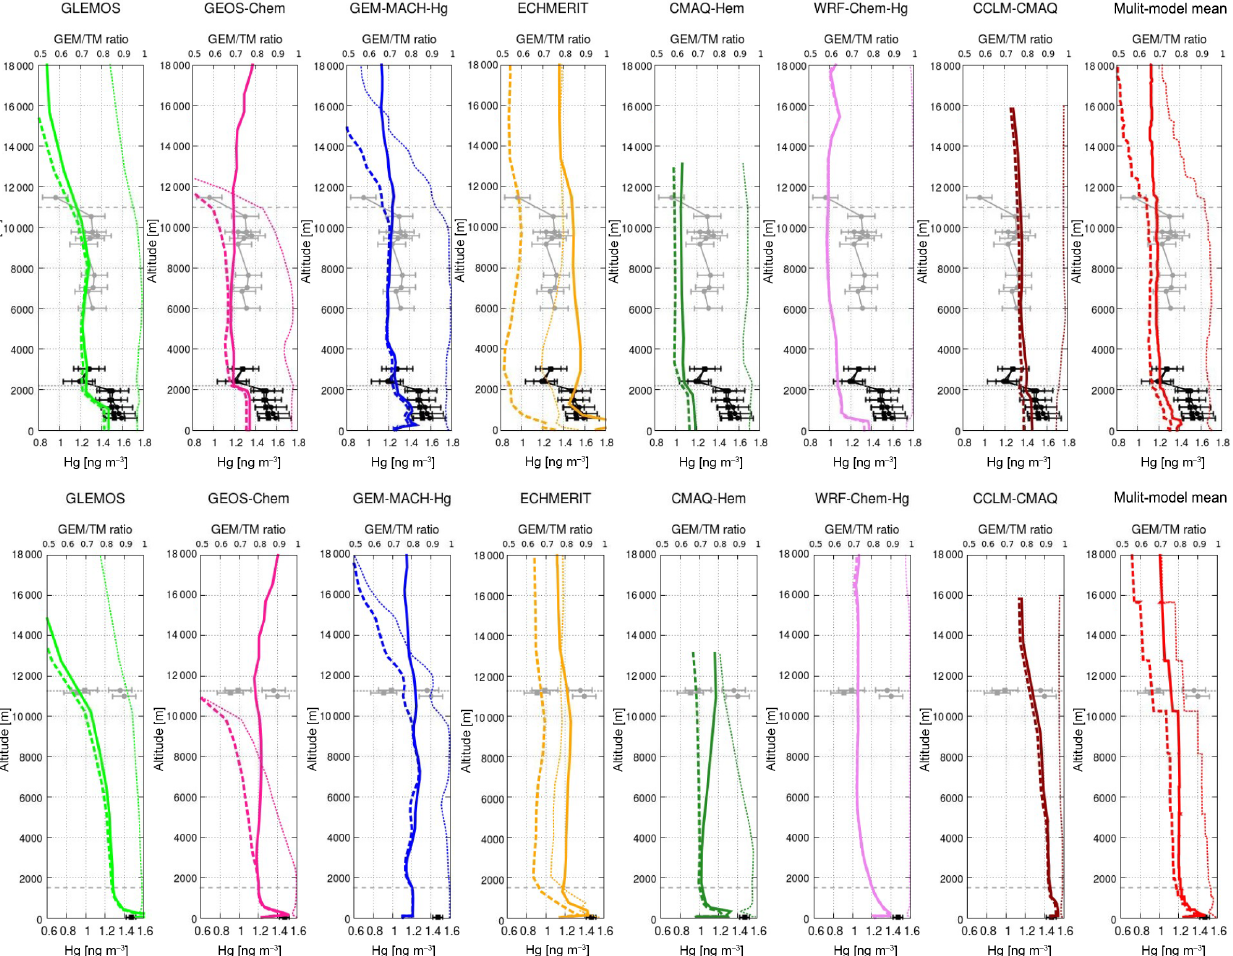
Figure 2. Upper panel: GEM / TGM profiles at Leipzig, Germany (21 August 2013), compiled from ETMEP and CARIBIC measurements (Weigelt et al., 2016). Lower panel: GEM / TGM profiles at Mace Head, Ireland (19 September 2013), compiled from GMOS ground- based observations (Weigelt et al., 2015) and CARIBIC measurements (Slemr et al., 2016). Solid lines indicate total mercury (TM), dashed lines indicate elemental mercury (GEM), and dotted lines depict the GEM / TM ratio given on the second x axis. The horizontal gray lines depict PBL and tropopause height. The black squares are ETMEP measurements, the gray circles are tropospheric, and the gray squares are stratospheric CARIBIC